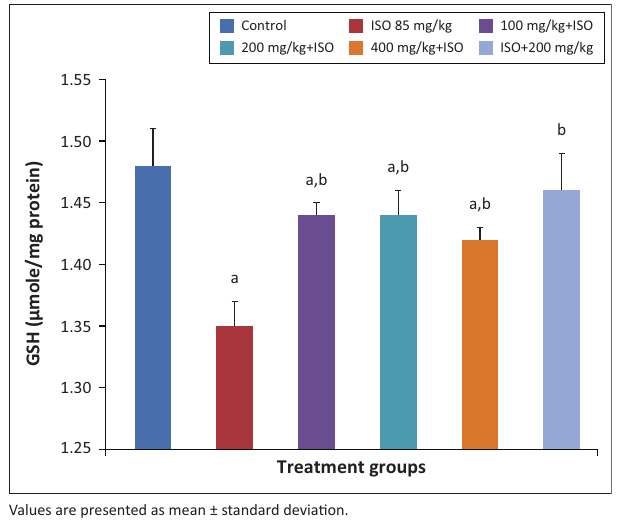
FIGURE 9: Effect of the ethanolic extract of Andrographis paniculata on hydrogen peroxide in isoproterenol-induced myocardial infarction using rats as a model ( n = 5).